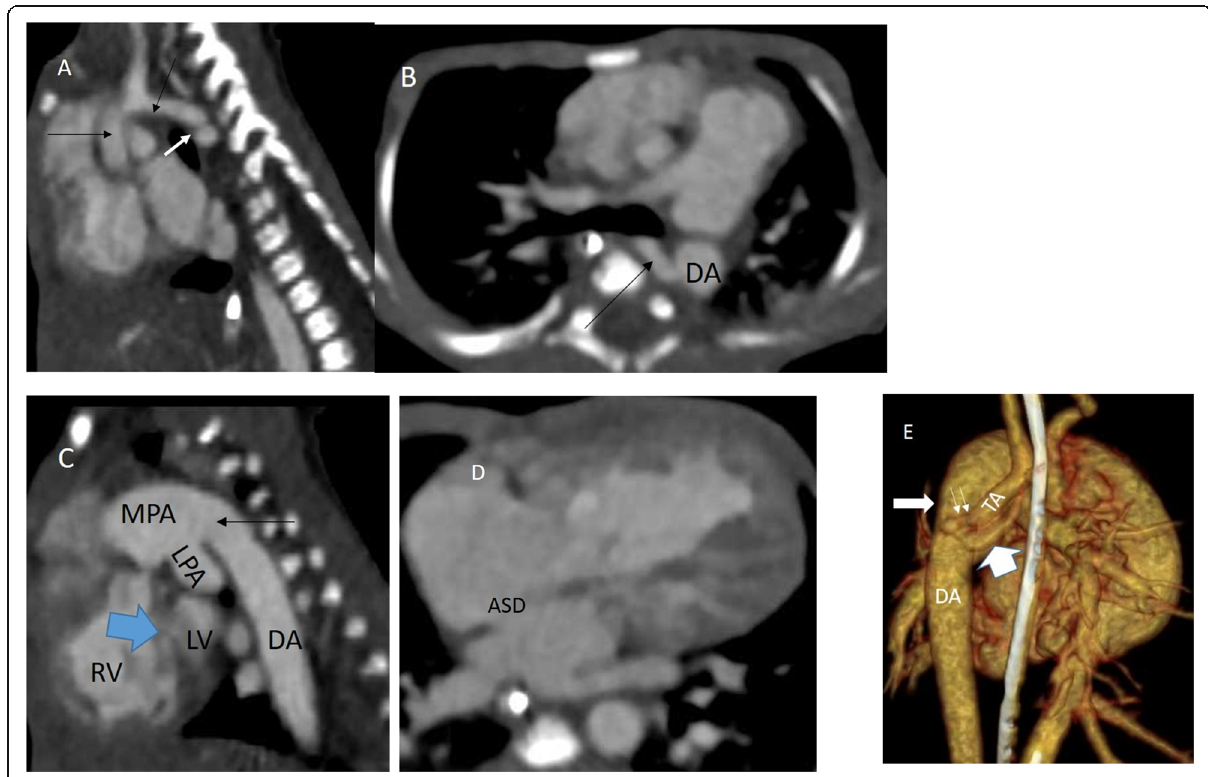
Fig. 6 A 10-day-old boy with distress and low blood pressure in bilateral lower and right upper limbs. a Sagittal CTA shows focal critical aortic coarctation (white arrow), small AA and aortic arch (black arrow). b Axial CTA: Aberrant right subclavian artery (RSCA) (arrow) arising from the cephalic part of DA distal to the coarctation. c Sagittal CTA: dilated MPA and LPA, large PDA (black arrow) supplying DA indicating duct dependent systemic circulation, VSD (blue arrow), small LV and enlarged RV. d Axial CTA: ASD and enlarged right side of heart. e 3DVR shows severe aortic coarctation (small arrows), large PDA (small block arrow), and aberrant RSCA (large black arrow) arises distal to the coarctation